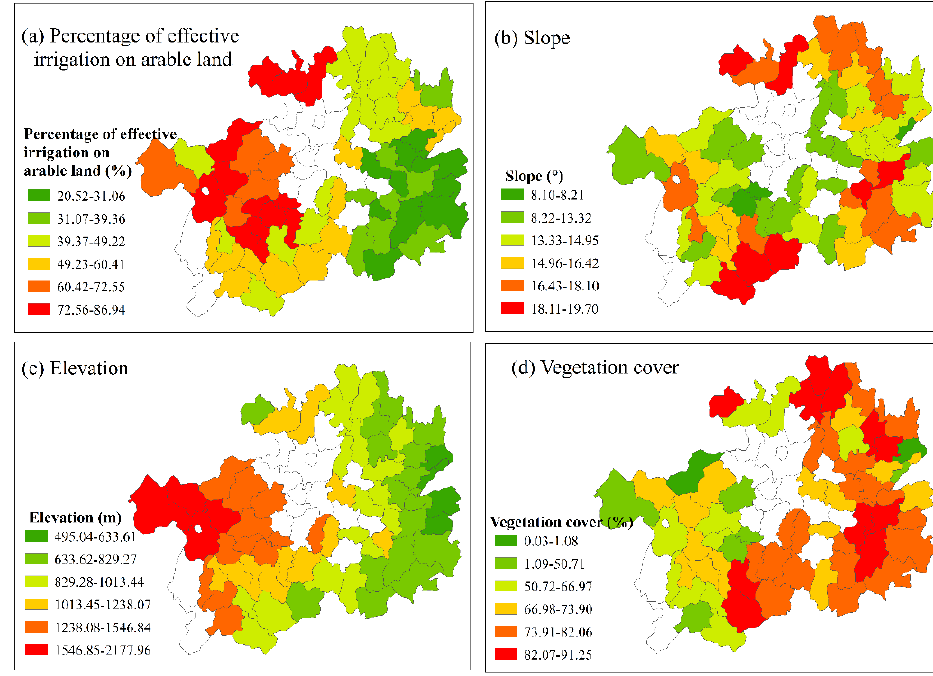
Figure 8. Distribution of dominant factors in Guizhou Province: ( a ) percentage of effective irrigation on arable land; ( b ) slope; ( c ) elevation; ( d ) vegetation cover. The graduation of the legends is consistent with discretization results of original explanatory variables.